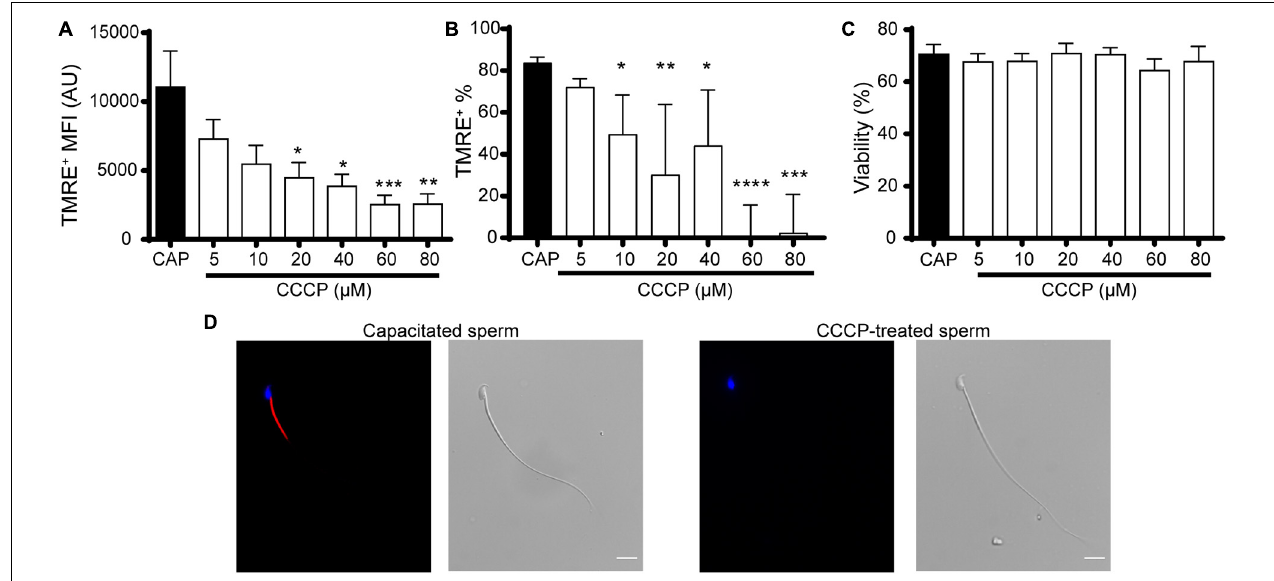
FIGURE 2 | Validation of TMRE as a probe for the analysis of mitochondrial membrane potential in mouse sperm. Epididymal sperm were incubated in the capacitation medium containing CCCP (5–80 µ M) or DMSO (capacitated sperm, CAP), loaded with TMRE, and at 90 min of total incubation fluorescence was measured by flow cytometry. The following parameters were scored: (A) Mean fluorescence intensity (MFI). (B) Percentage of TMRE+ sperm. (C) Percentage of sperm viability. Results are expressed as mean ± SEM in (A,C) and median with interquartile range in (B) . In all cases, at least 3 independent experiments were performed. * p < 0.05, ** p < 0.01, *** p < 0.001, **** p < 0.0001. (D) Representative fluorescence and phase-contrast microscopy images showing TMRE (red) and Hoechst 33342 (blue) staining patterns of capacitated (left) and CCCP-treated (right) sperm. n = 3. Bar = 10 µ